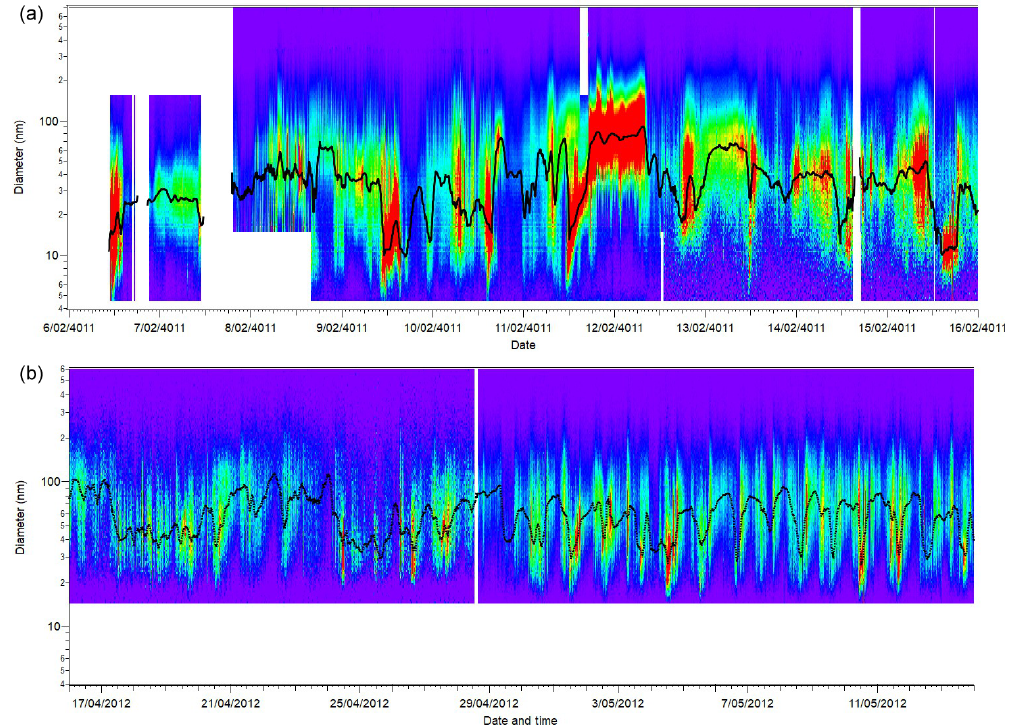
Figure 1. Time series of aerosol size distribution for SPS-I (a) and SPS-II (b) . The black line on each plot is the mode diameter. Contour plots were produced using SMPS Loading and Processing Functions version 1.8.8 authored by Tim Onasch from Aerodyne Research,